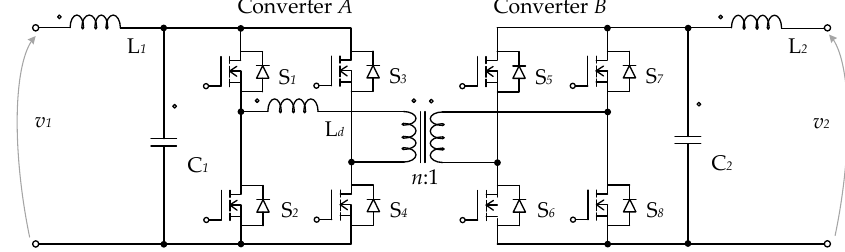
Figure 1. Conventional dual-active bridge converter, commonly found on bidirectional applications.